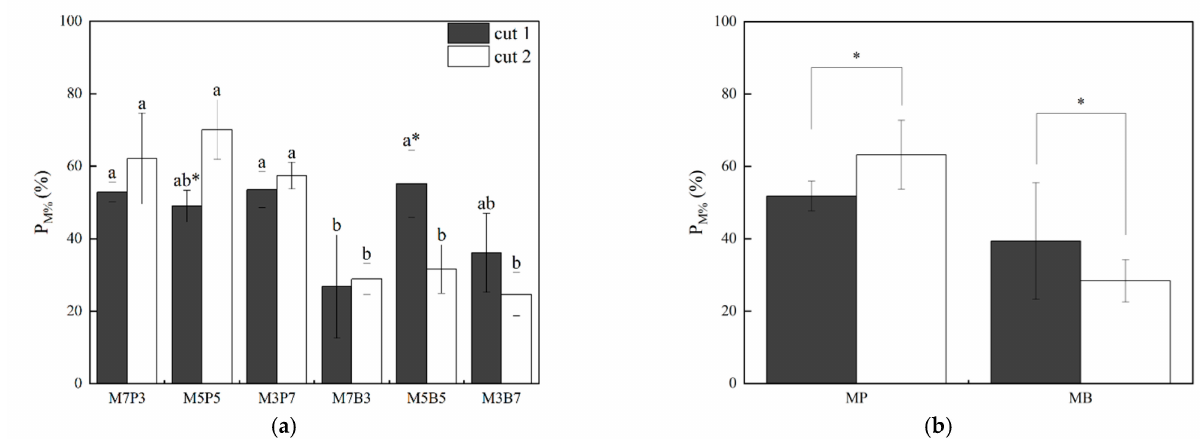
Figure 2. The proportion of lucerne P uptake in total grassland ( a ), (P M% ) in different cuts of mixtures and ( b ) cut-level P M% under different species combinations. Values are the means ± SD (n = 3 in a and n = 9 in b). Different lowercase letters indicate significant differences ( p < 0.05) among mixtures of the same cut. Asterisks (*) show significant differences between two cuts of the same mixture at p < 0.05.